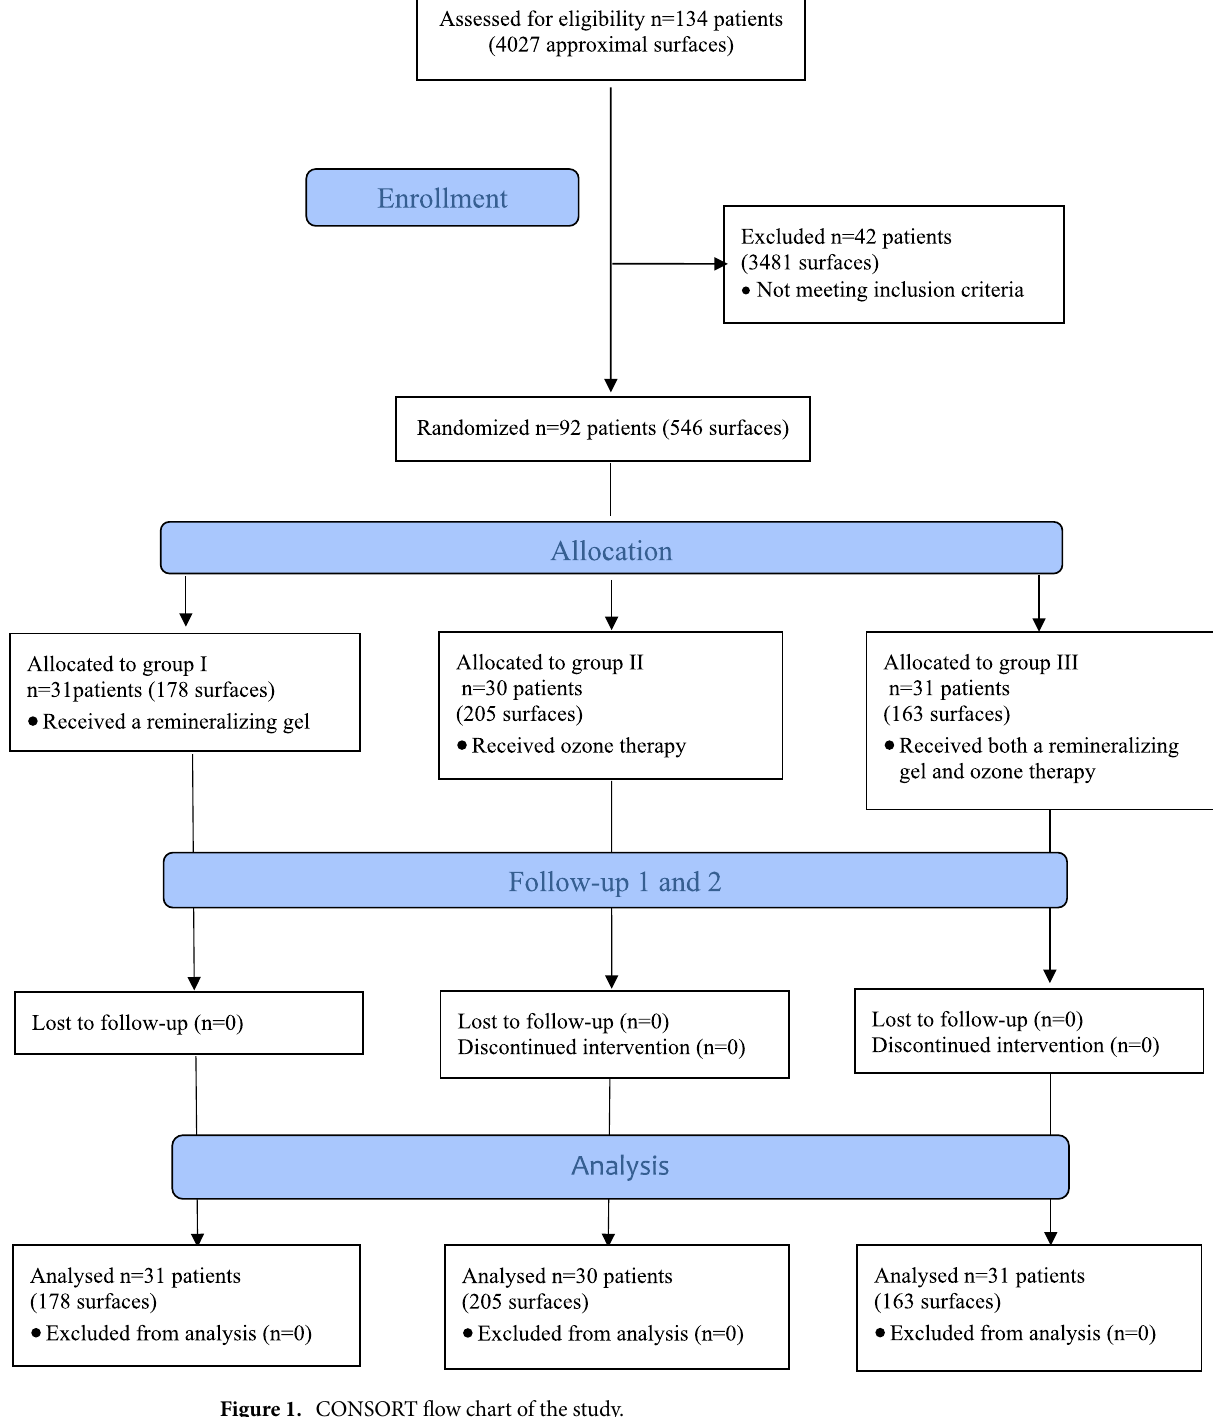
Figure 1. CONSORT flow chart of the